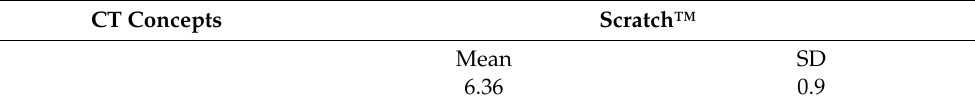
Figure 1. Flowchart of the sessions, assessment concepts and tools used. 1: Mean and standard deviation for each student and competence. 2: Mean and standard deviation for each student and CT concept. Table 6. Mean and standard deviation of CT concepts demonstrated when using Scratch TM .